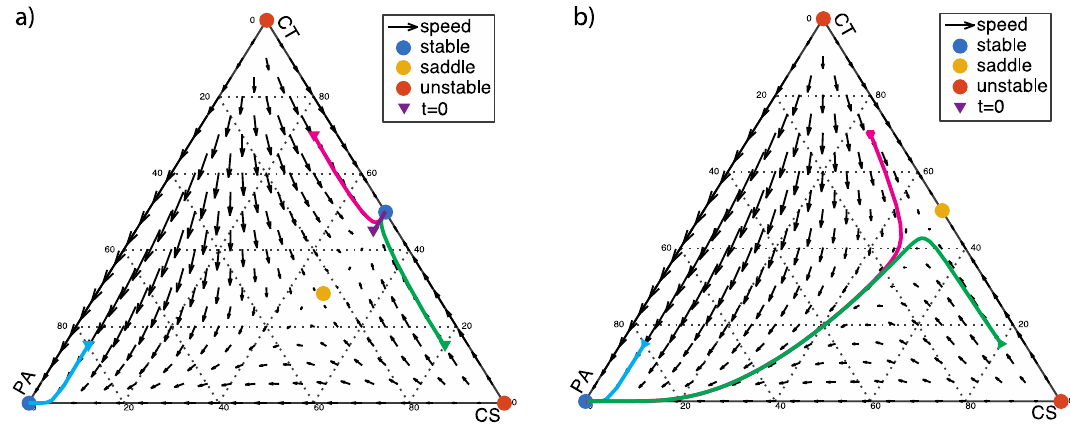
Figure 3. α > 0 and β < 0: The two vertices of the simplex with pure commensal populations (CS and CT) at (1, 0, 0) and (0, 1, 0) are unstable fixed points. ( a ) α < β + 1, α = 0.5, β = − 0.2; a saddle point with the coordinates given by Equation 4 emerges in the interior of the simplex; ( b ) α > β + 1, α = 1, β = − 0.2.